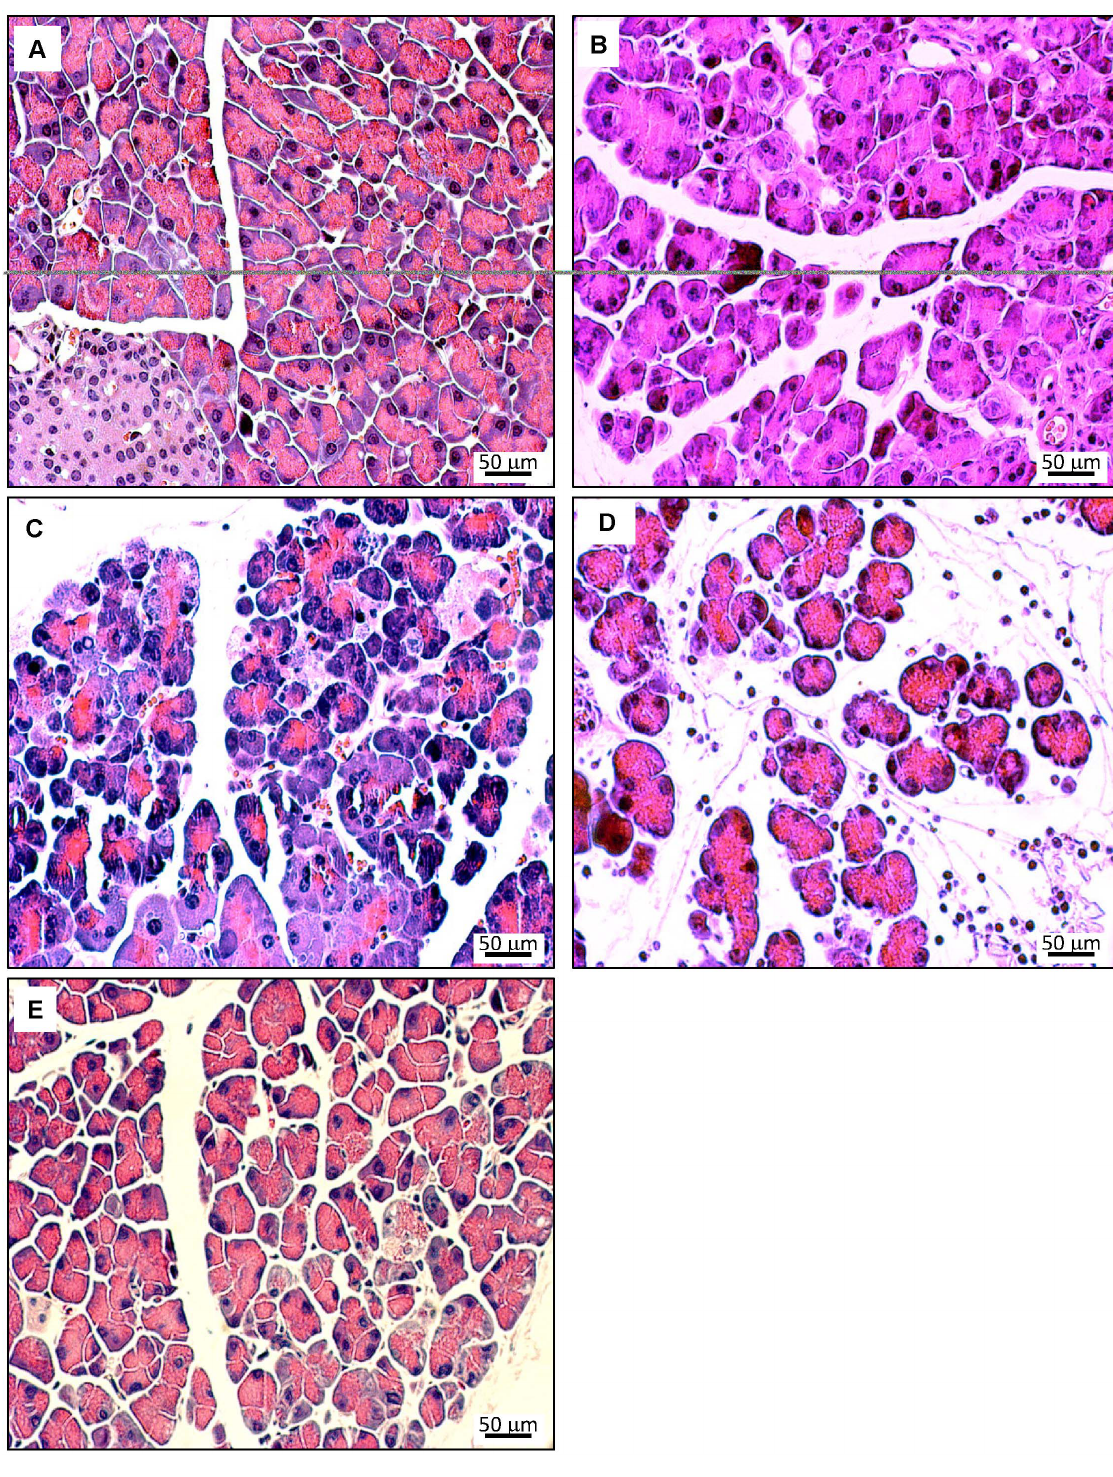
Figure 4. Histopathology of pancreatic lesions in cerulein-treated 12 months old UCP2 -/- mice. Pancreatic sections were stained with H&E. Photographs A–E display representative examples of pancreatic damage at the time points 0 h, 3 h, 8 h, 24 h and 7 days after the start of cerulein treatment. In addition to the findings described in Fig. 3, more pronounced histopathological changes at the time points 24 h (D – edema and presence of interstitial inflammatory cells) and day 7 (E – edema and cell damage) were observed.